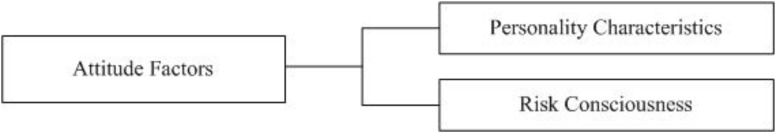
LBCC model based on attitude factors.